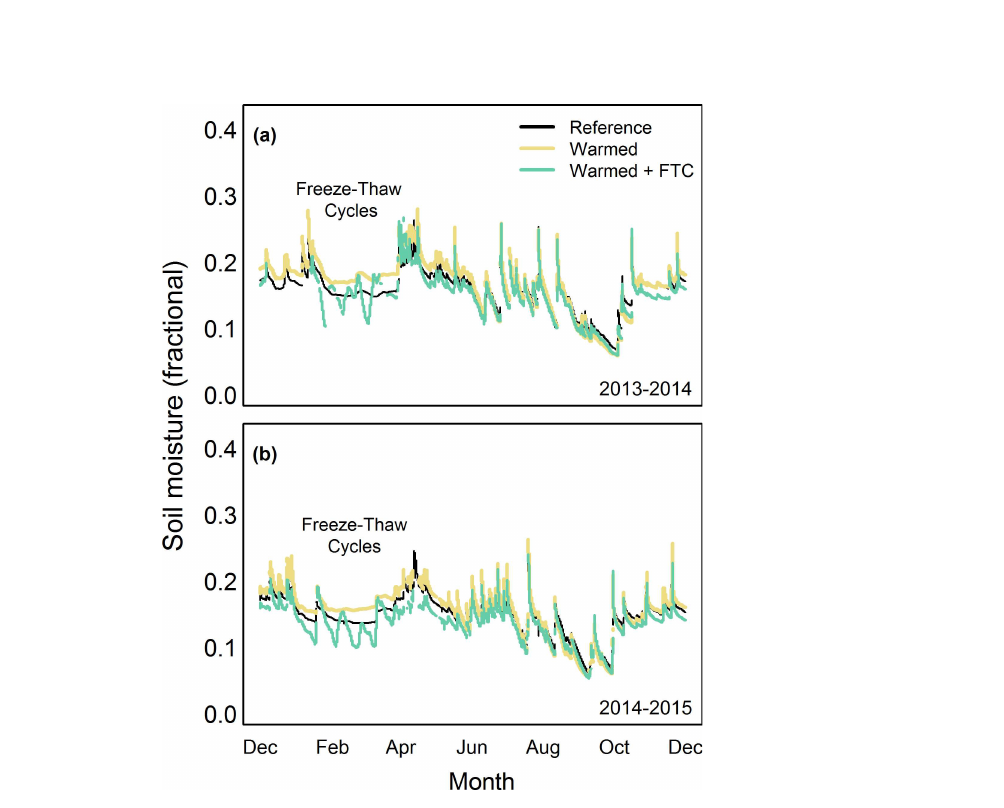
Fig 5. Soil moisture integratedfrom 0–30cm depth from a) December 2013to December2014 and b) December 2014 to December 2015 averaged by treatment for each